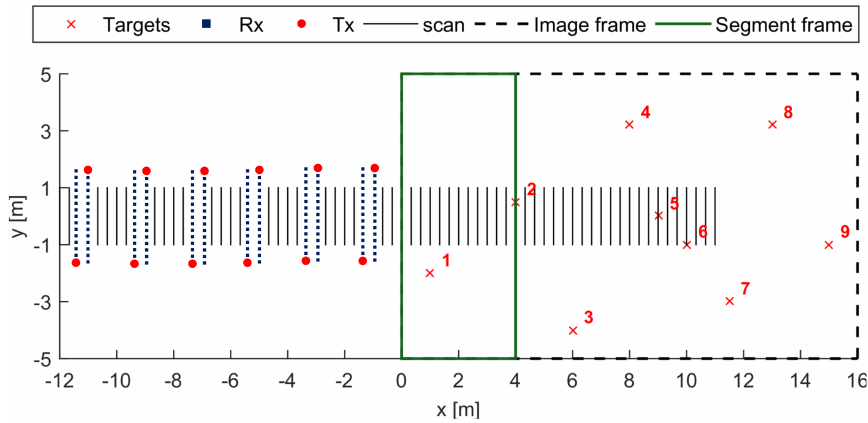
Figure 2. Top view of the numerical simulation geometry. Six different full-aperture measurements have been highlighted in blue, which are used in coherent combining for the first image segment indicated in green (the positions of transmitters and receivers are not drawn to scale within the image frame).